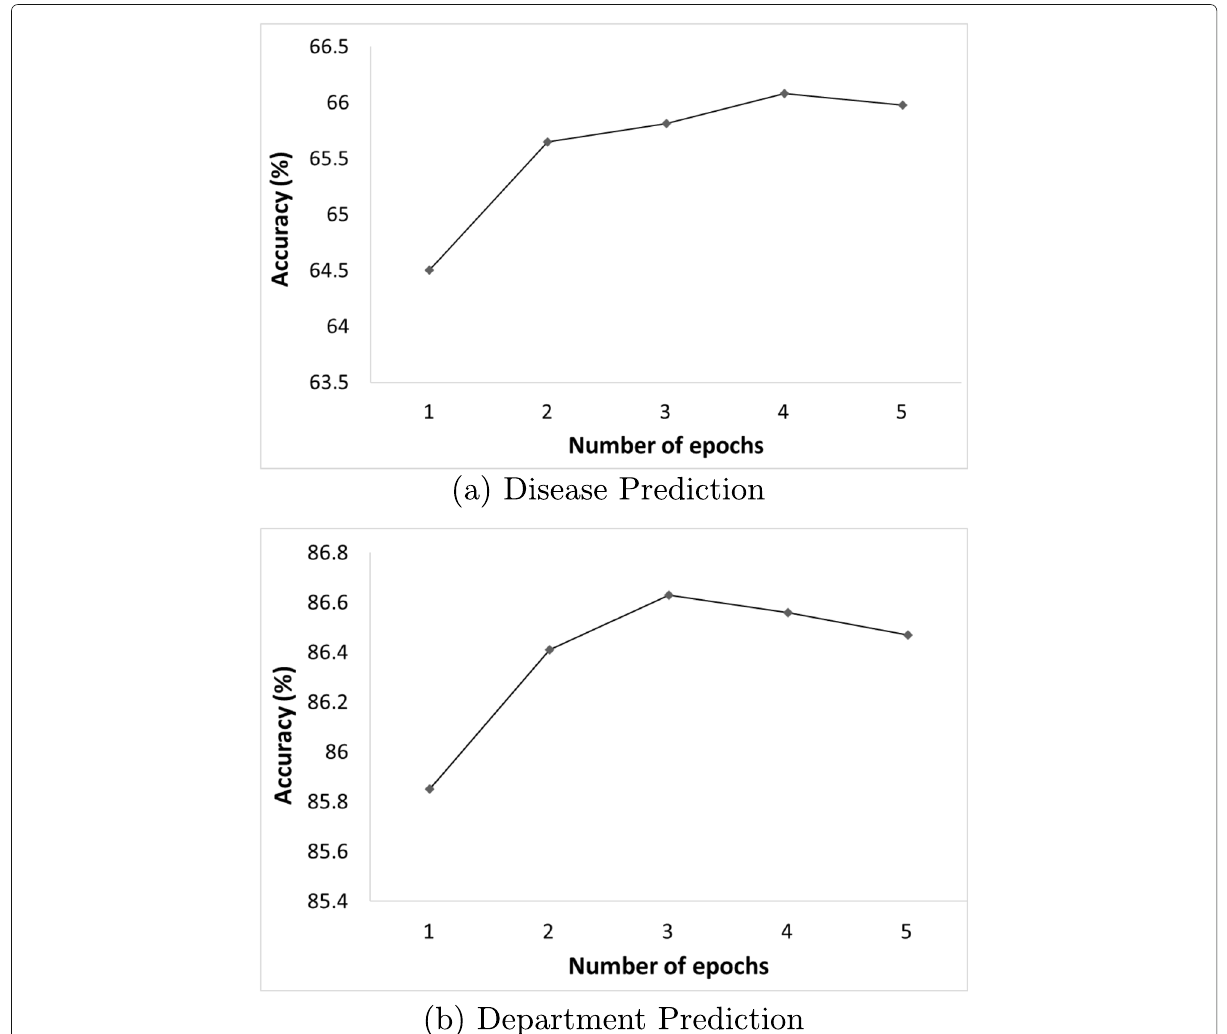
Fig. 4 The prediction accuracy with different epochs when the learning rate was 2e5